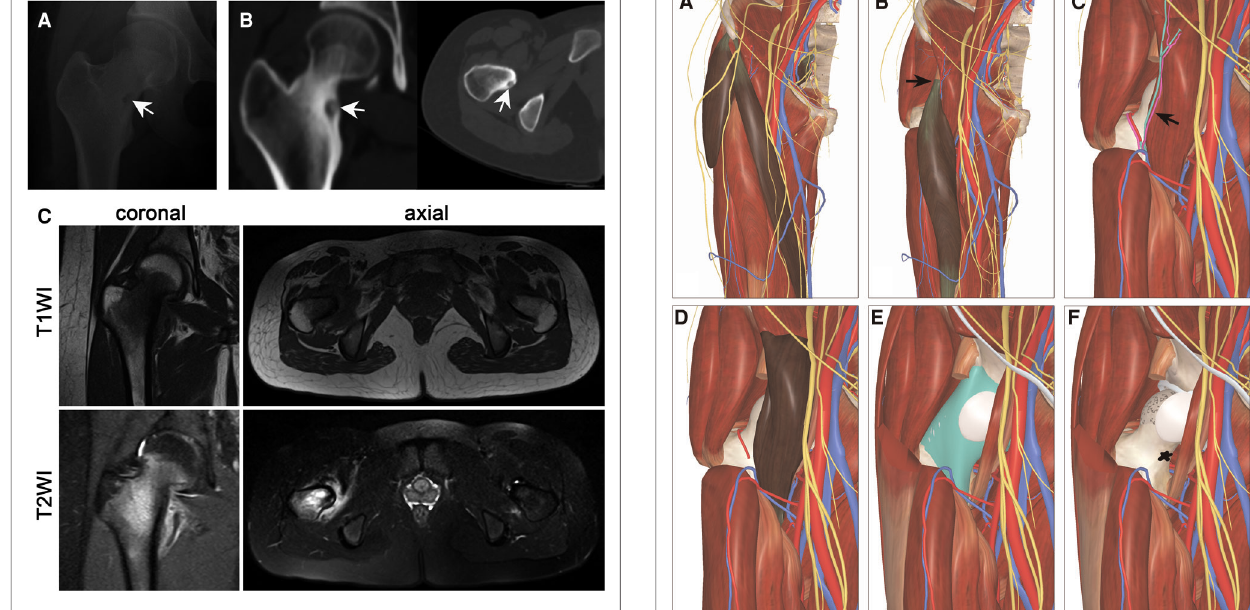
examination lacks speci fi city, T1WI shows low to moderate signal intensity and T2WI shows moderate to high signal intensity.